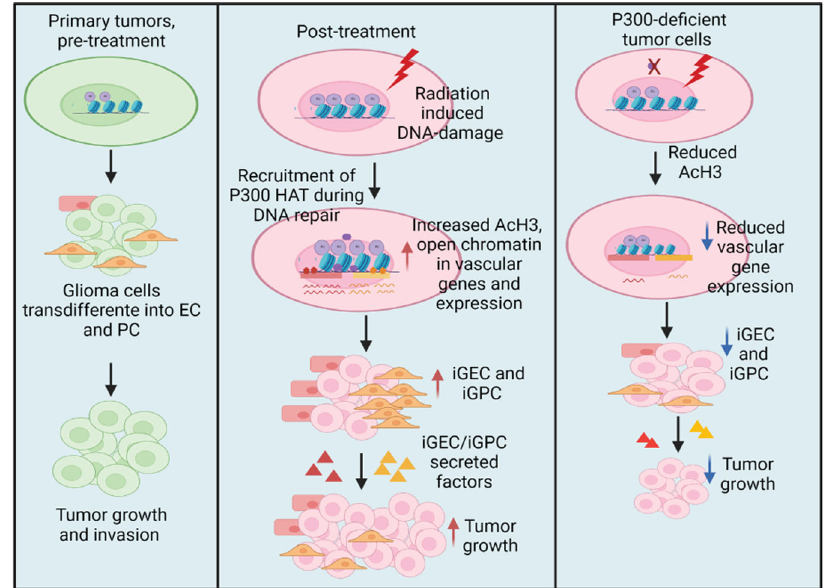
Fig. 8 | Model illustrating radiation-induced vascular-like phenotype conversion in glioma stem- and tumor cells via a p300-dependent